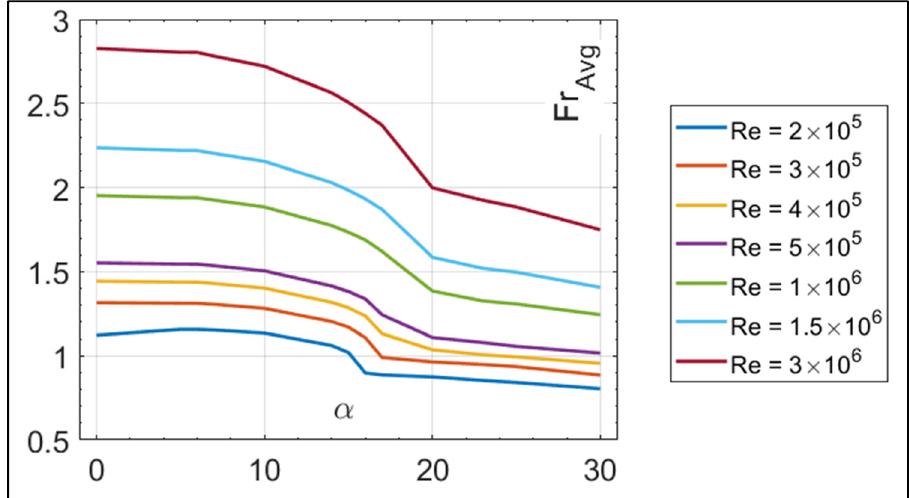
Figure 6. Average Fr variation with respect to Re and α .